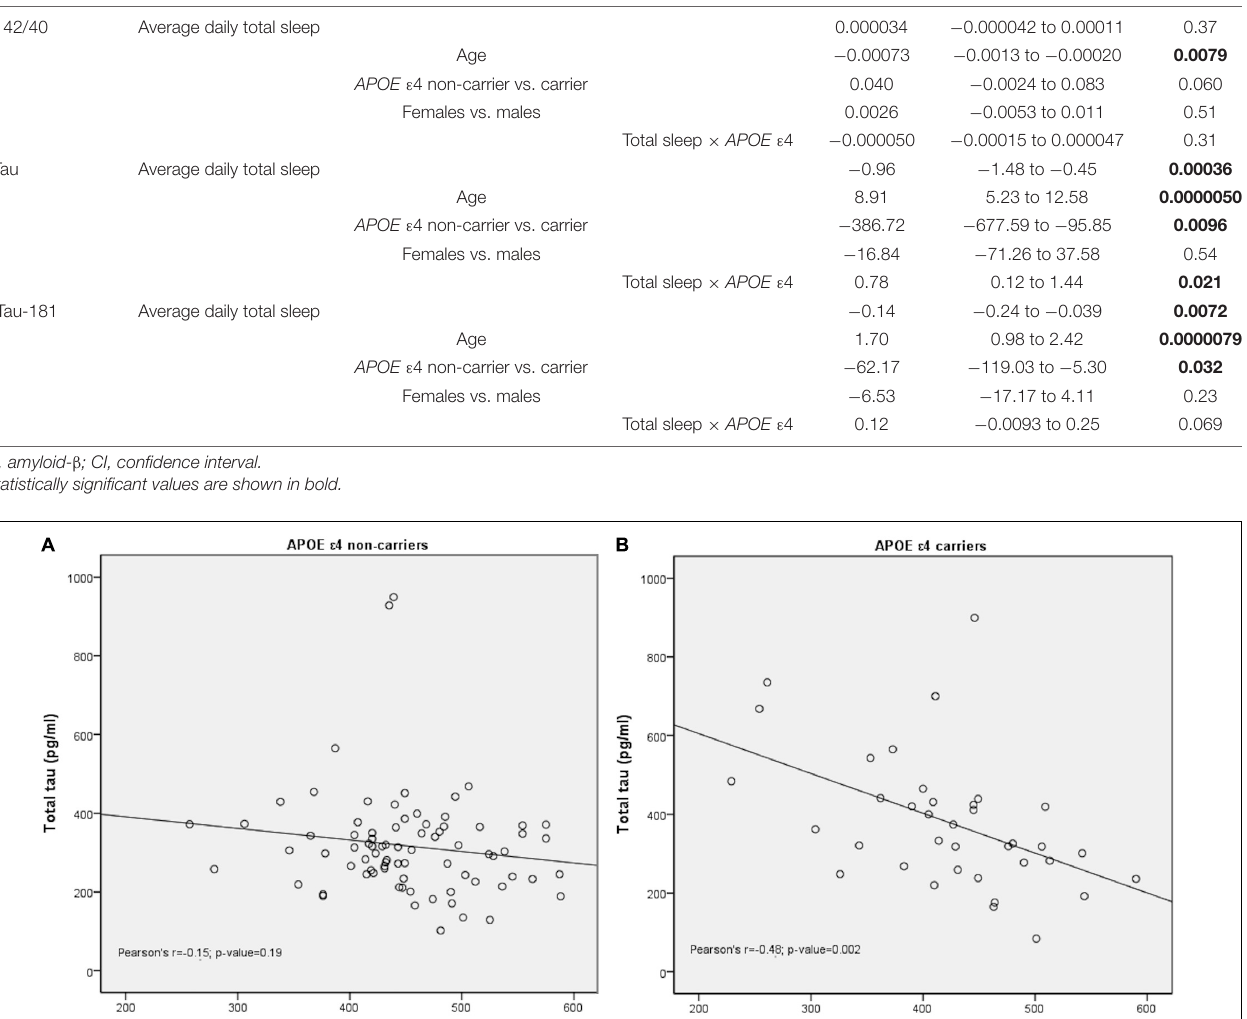
TABLE 2 | Relationship between sleep and CSF AD biomarkers after adjusting for age, sex, and APOE 4 status. CSF biomarker